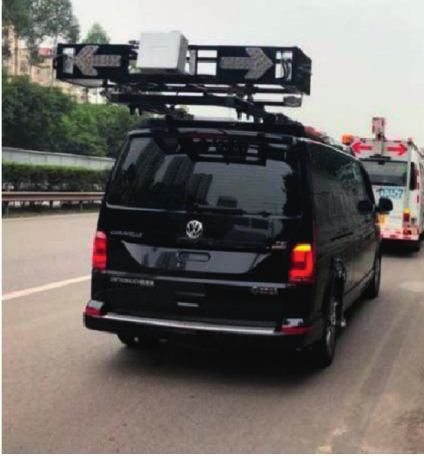
Figure 1: Intelligent road measuring vehicle (luxin-CT616).